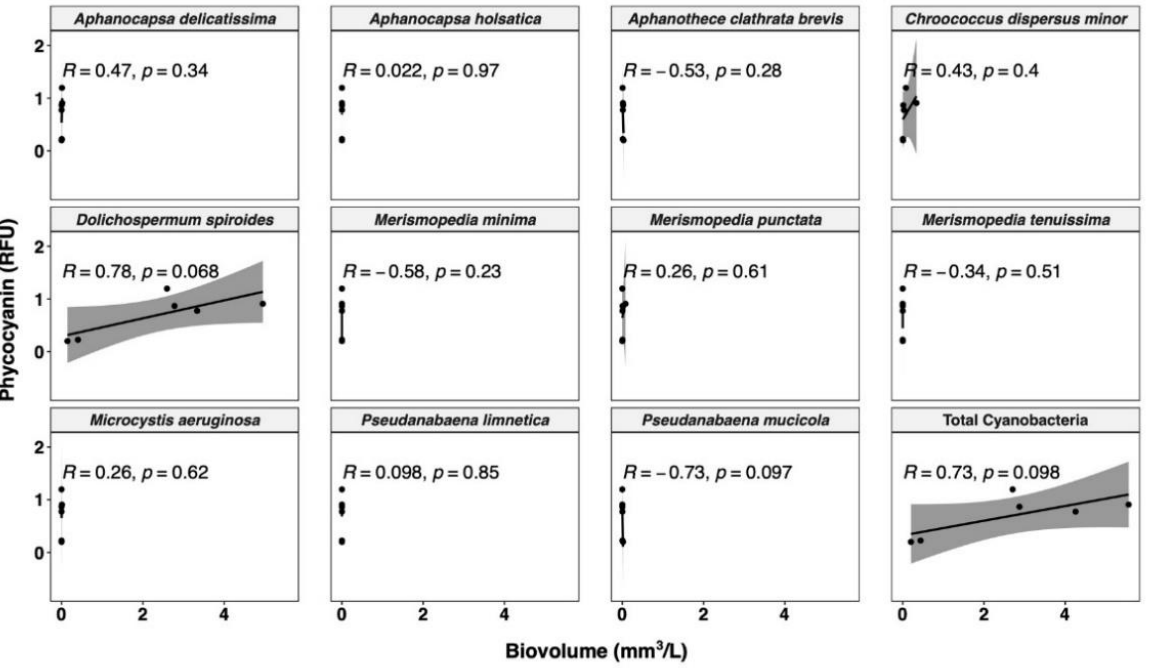
Figure 5. Relationship between phycocyanin probe readings and cell biovolume for different cyanobacterial species. Shaded area around line represents 95% confidence interval.